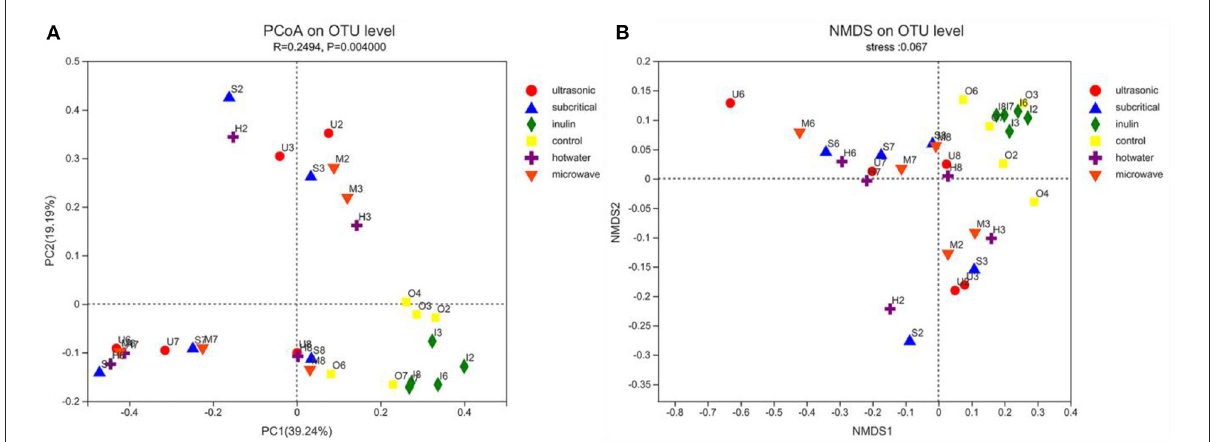
FIGURE5 (A,B) The PCoA and NMDA plots show the β diversity of the fecal microbiota ( n = 5). Control stands for blank control group. The hot water, ultrasonic, subcritical, and microwave stand for dietary fiber extracted with hot water, ultrasonic assisted, subcritical water, and microwave assisted methods,